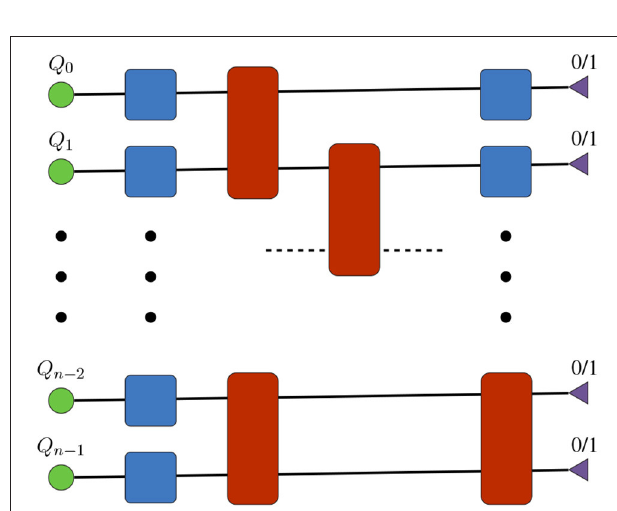
FIGURE 5 | ExaTN tensor network for bit-string amplitude computation. The tensor network representing the input quantum circuit is constructed as described in Figure 4 . Triangular-shaped order-1 tensors are 0/1 tensors, representing the projected state.